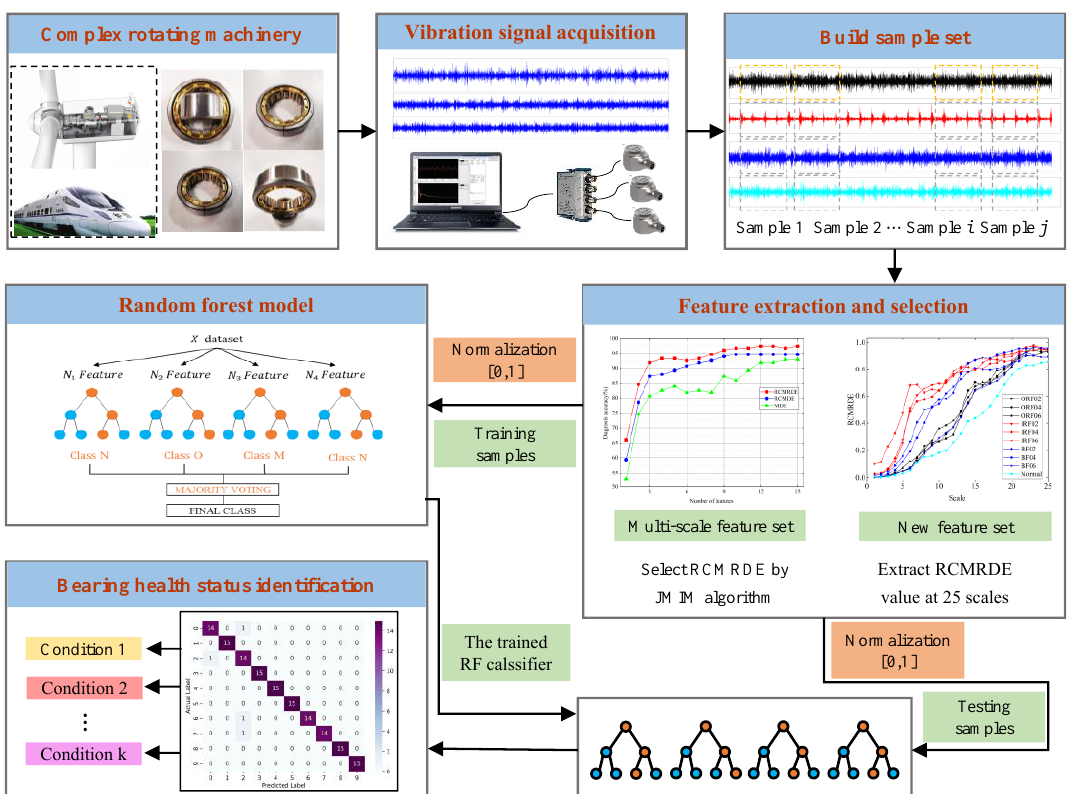
Figure 6. The flowchart of the proposed method.